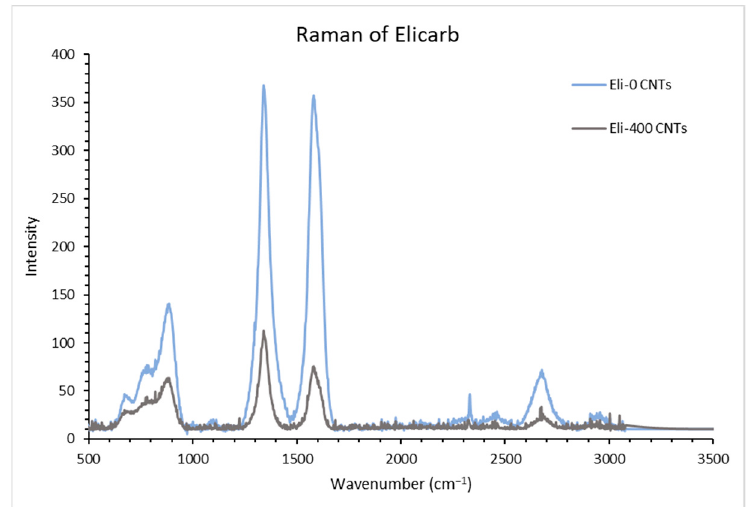
Figure 6. Raman spectra of the milled and unmilled Elicarb CNTs.